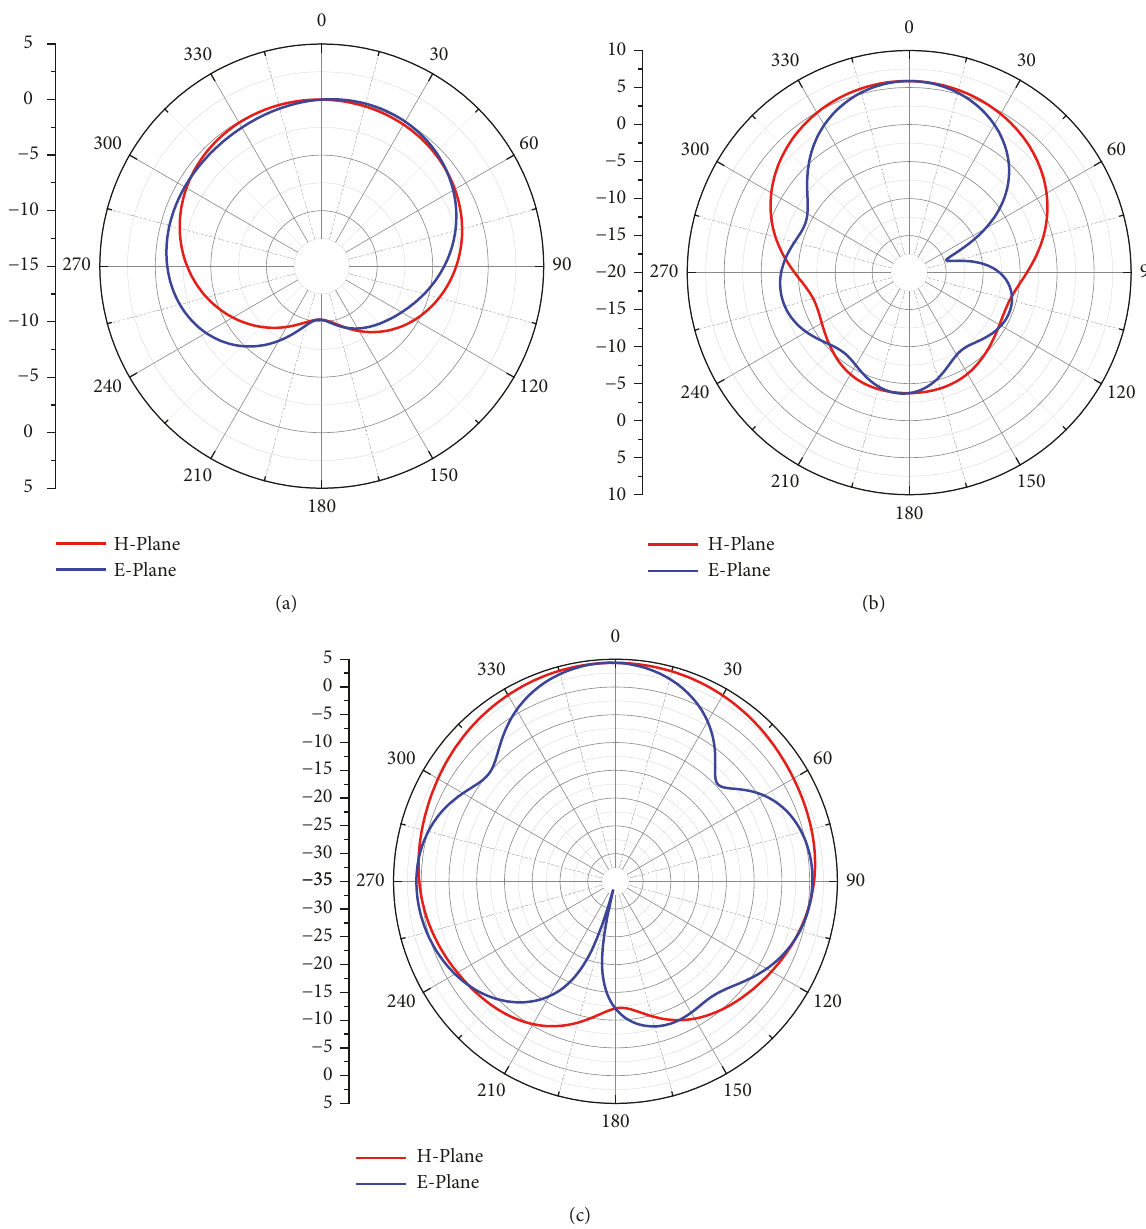
Figure 6: E-plane and H-plane radiation patterns of the DRA element (a) at 7 GHz, (b) at 12 GHz, and (c) at 15GHz.